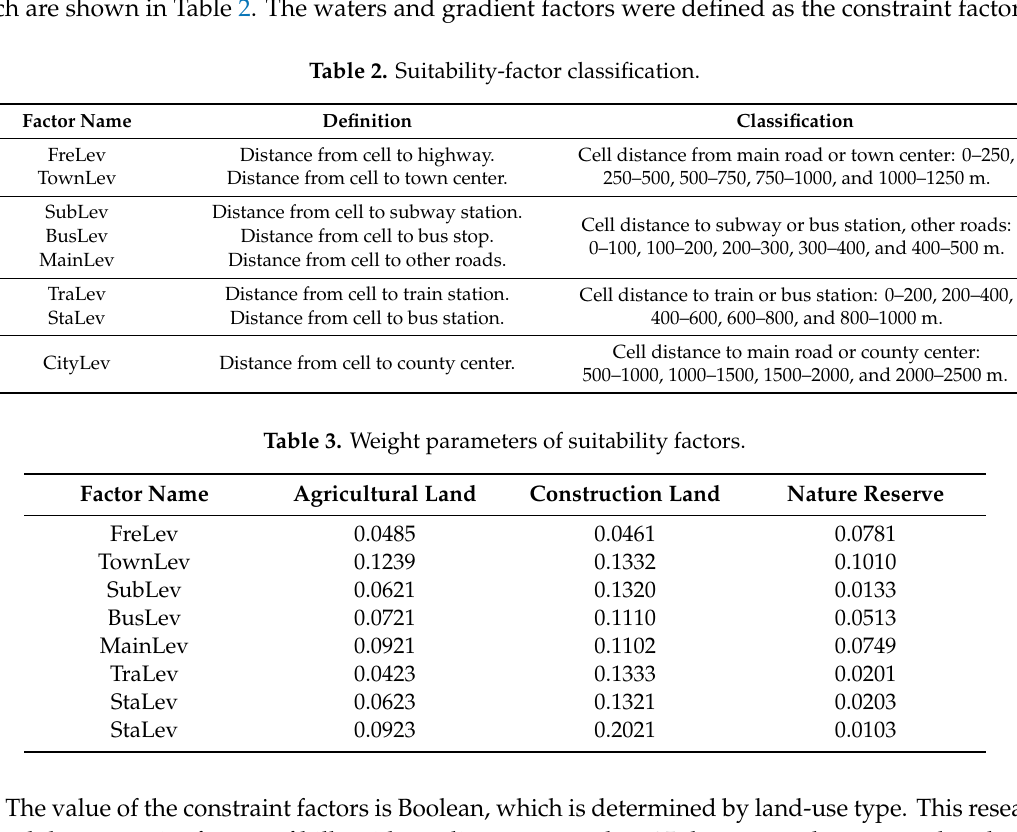
Figure 7. Cellular-dimension reduction.